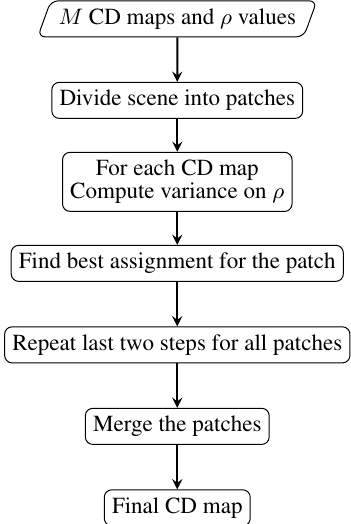
Figure 2. Method for combining results from multiple models. which are either concentrated on the very small values (for un- changed pixels) or very large values (for changed pixels), thus producing higher variance score. Thus the optimum model for a particular patch can be determined by maximizing variance computed on ρ